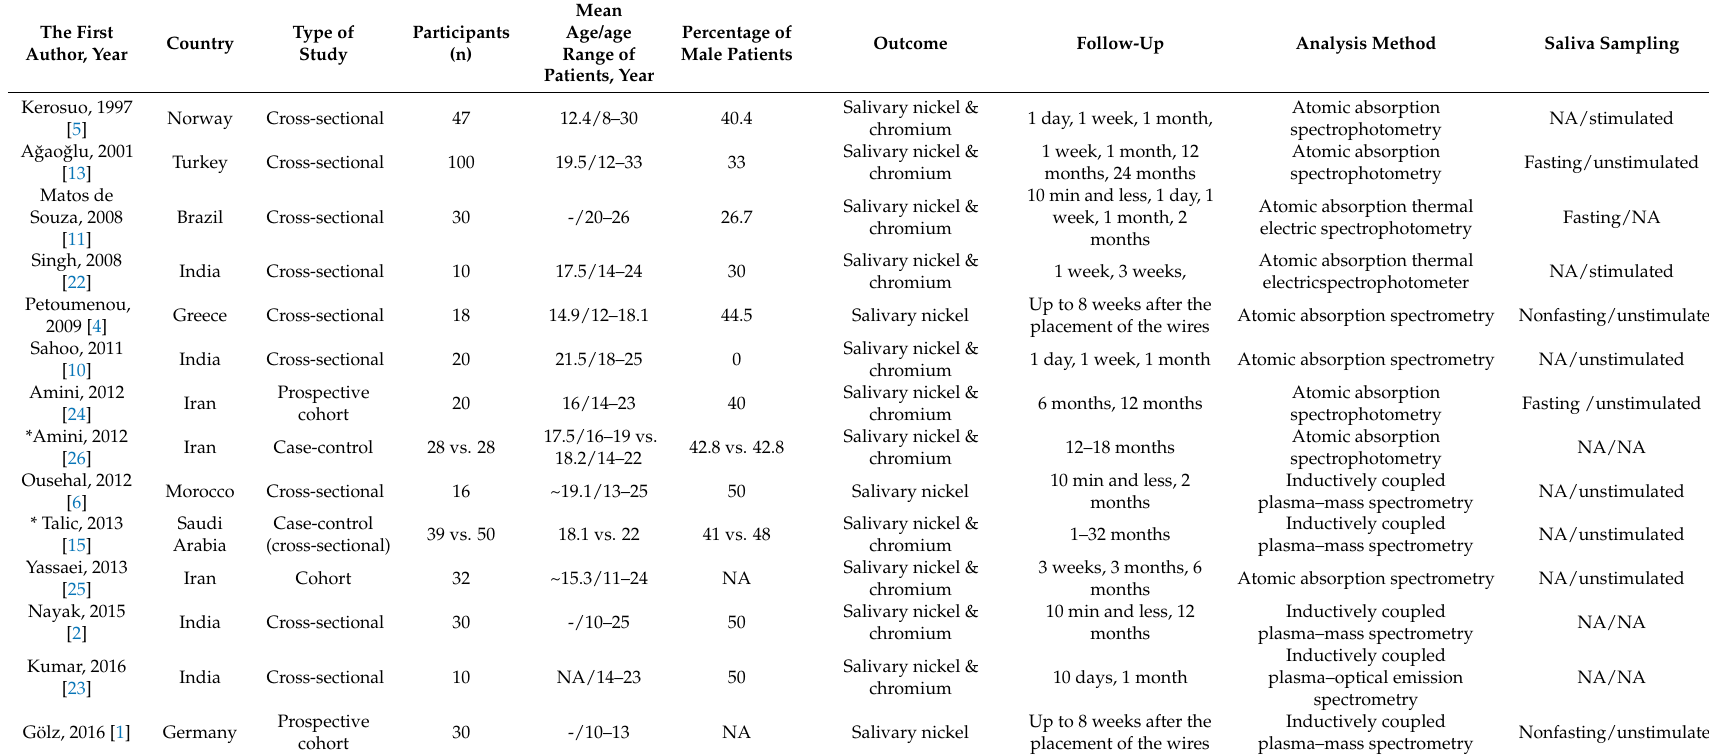
Table 2. Characteristics of the studies included in this meta-analysis (n =